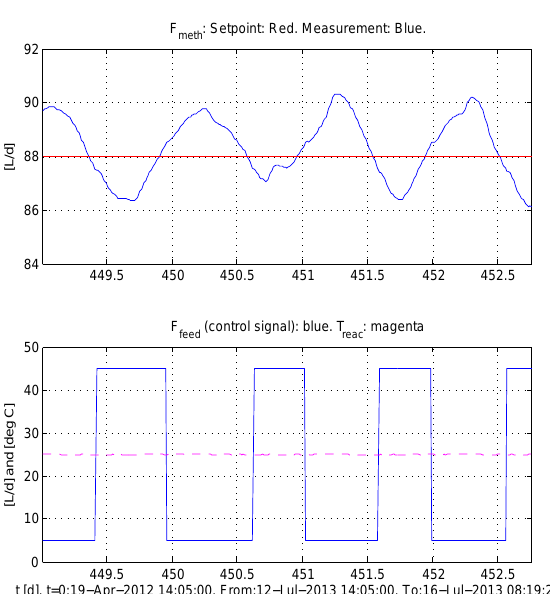
Figure 6: Experimental F meth with on-off methane gas flow